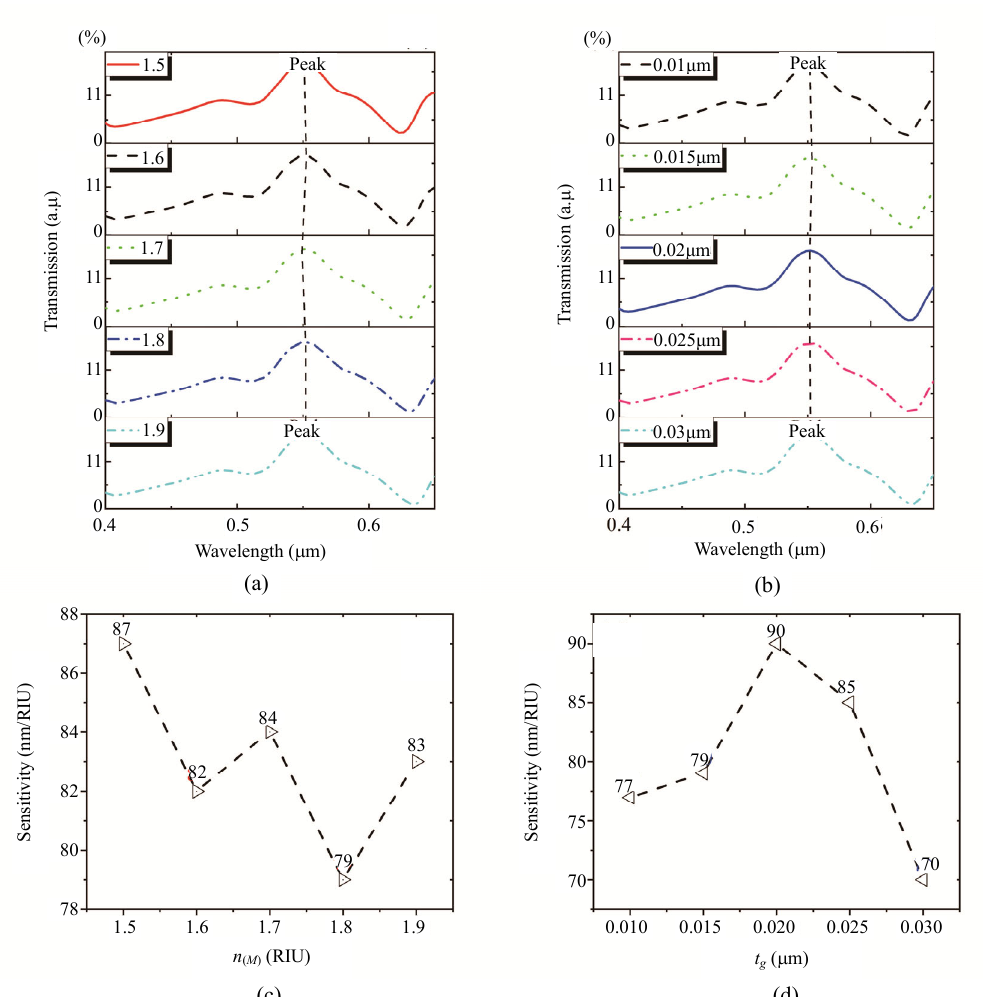
Fig. 4 Calculated zero-order transmission spectral dependence on different (a) the dashed black arrows indicate the shift of the different